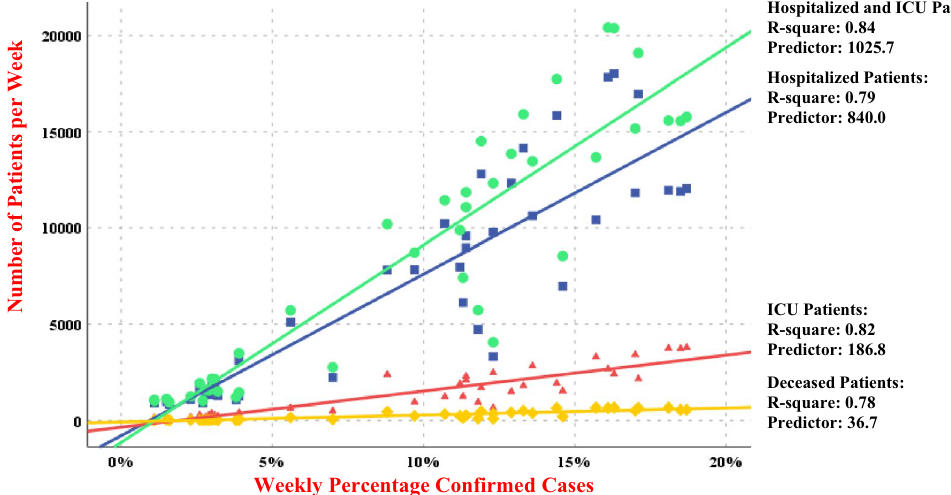
Figure 3. Linear distributions from March to December 2020 with 2-week